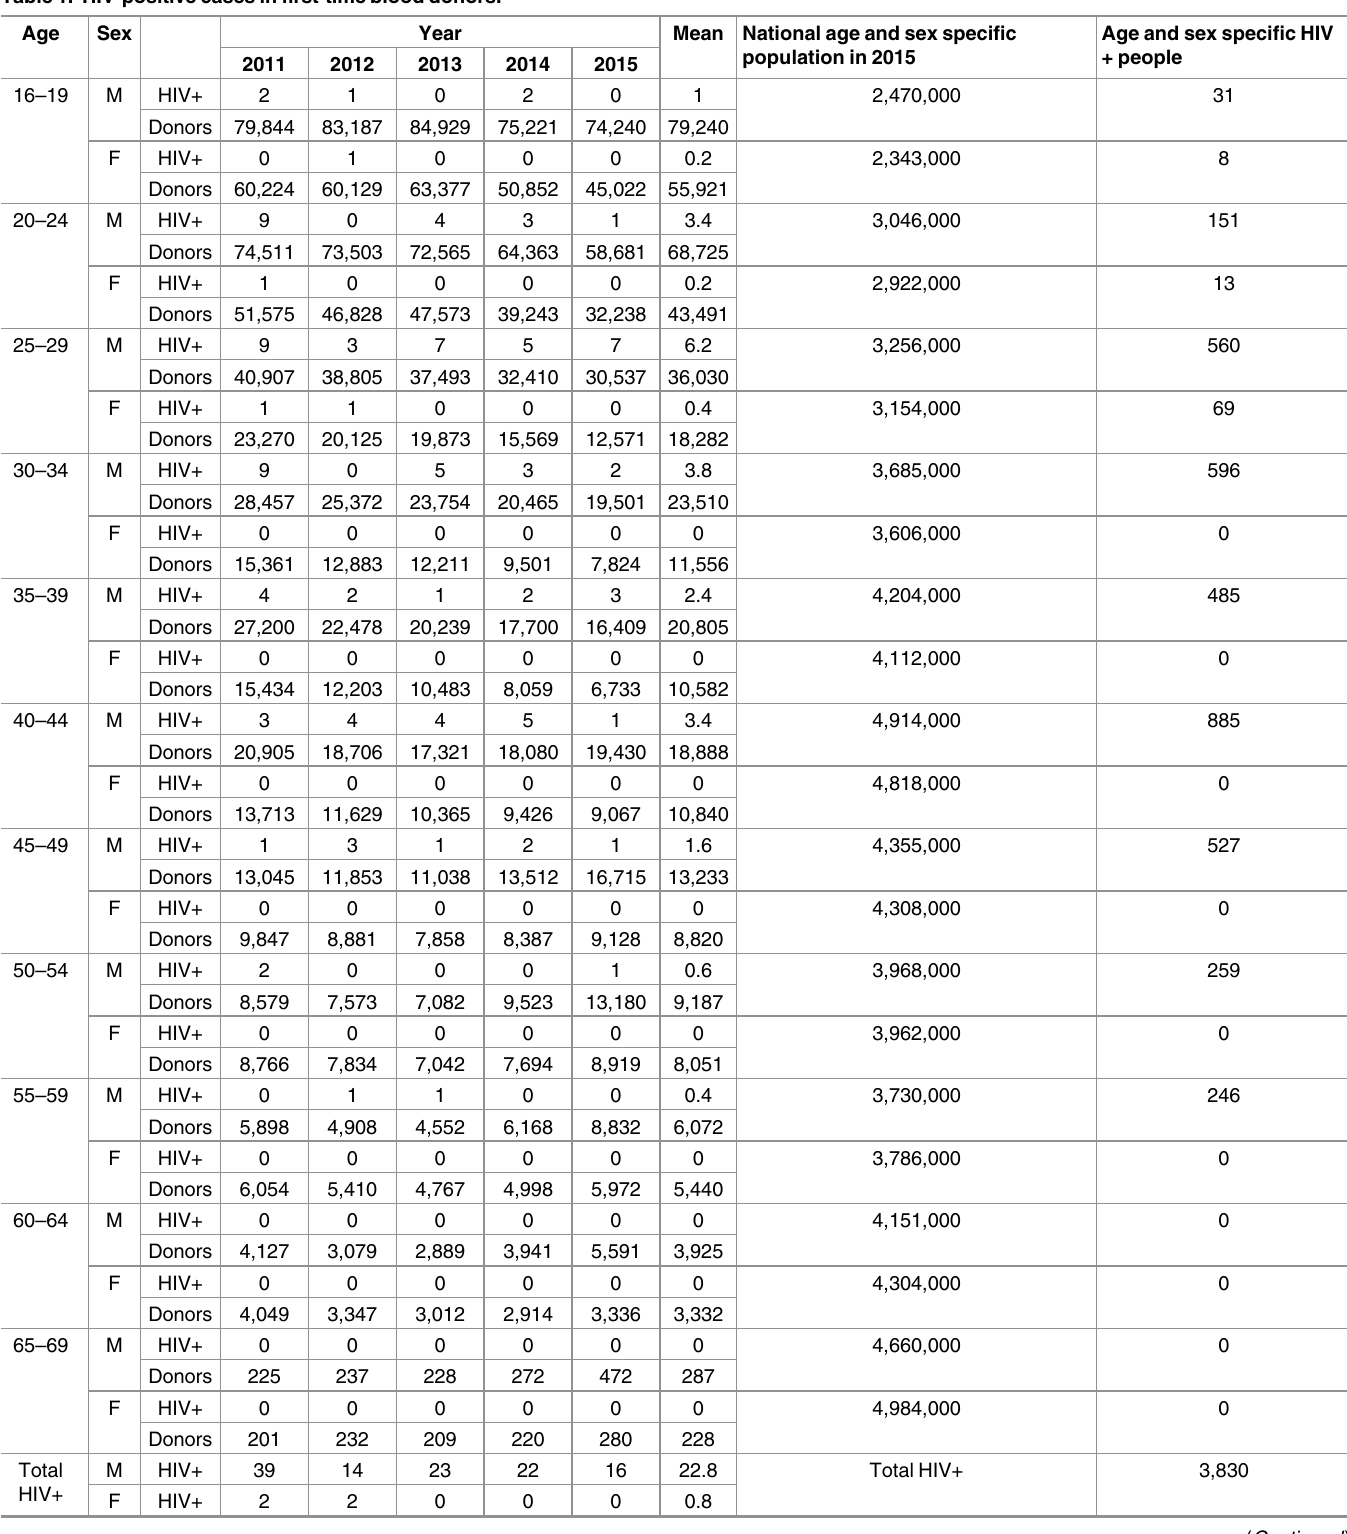
Table 1. HIV-positive cases in first-time blood